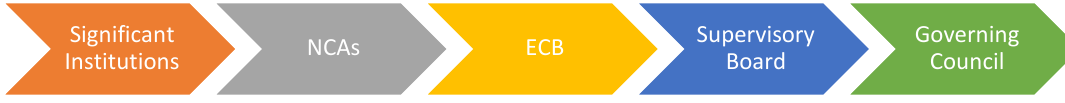
Figure 3. Stakeholders involved in fit and proper